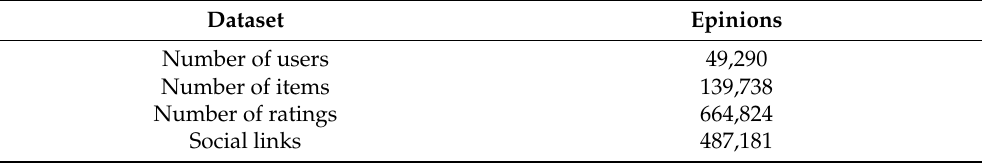
Table 1. Statistics of the experimental